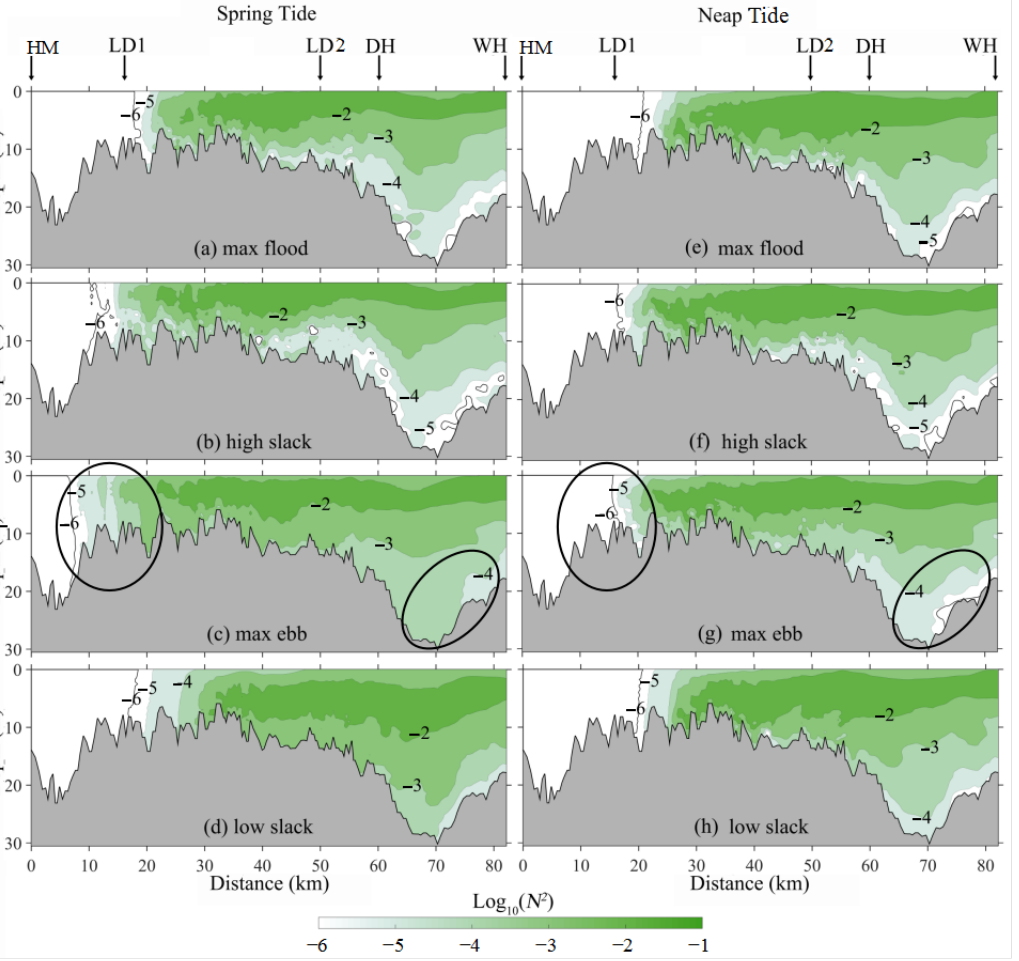
Figure 9. Longitudinal distributions of the square of buoyancy frequency log 10 ( N 2 ) along the channel (from stations HM to WH) at the West Channel in the Pearl River Estuary on a spring tide (left panels) and a neap tide (right panels) in the wet season.